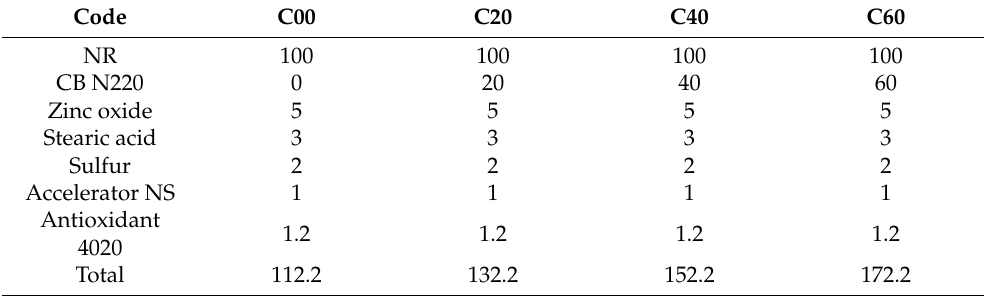
Table 1. Formulas and codes of four kinds of carbon black-filled vulcanized rubber (UNIT: